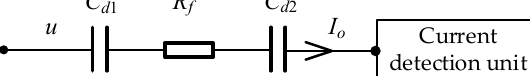
Figure 7. Equivalent circuit of the measurement path of the logging instrument.